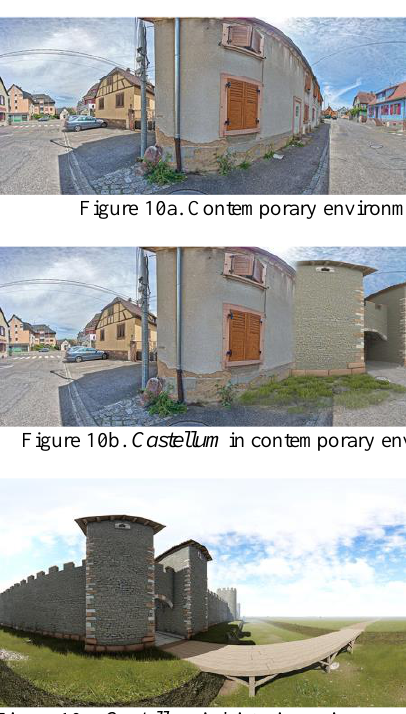
Figure 10c. Castellum in historic environment (4 th century)